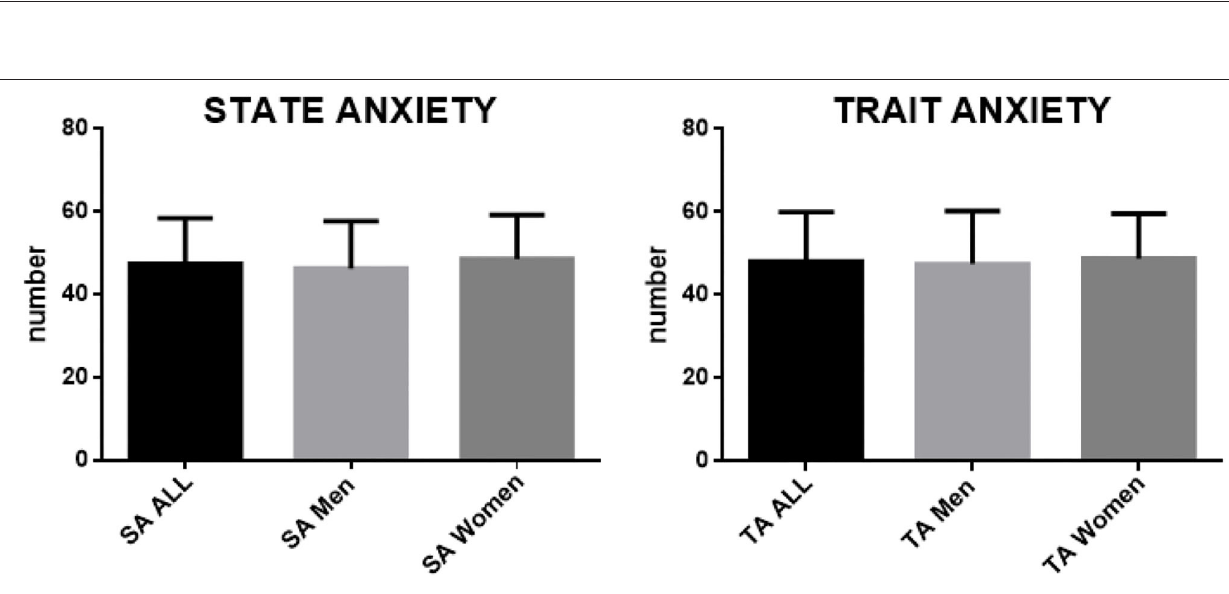
FIGURE 2 | State and trait anxiety values, both of the total sample, and separately for men and